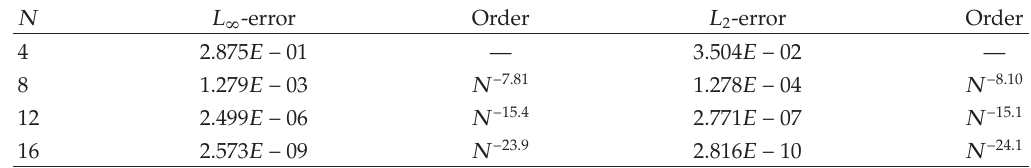
Table 1: Convergence rates at t (cid:7) 1 with μ (cid:7) 0, α (cid:7) 1, β (cid:7) 1, γ (cid:7) 3, n (cid:7) 2.